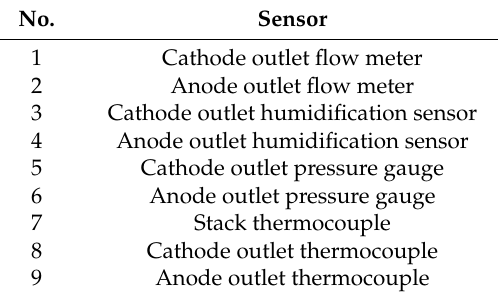
Table 2. Sensors used in the fuel cell test.